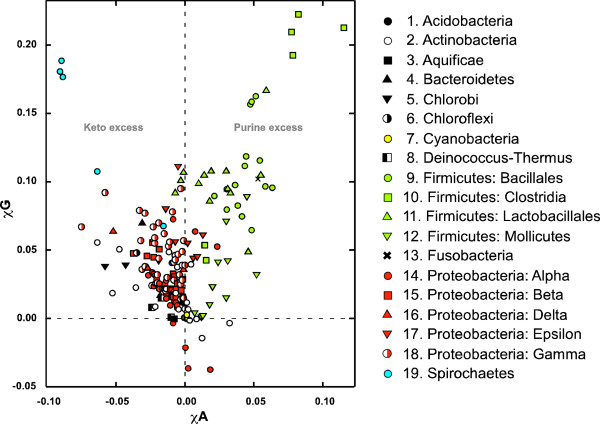
Scatter-plot analysis of base composition skews – χG vs. χA. The χG values and χA values of 185 bacterial chromosomes are plotted against each other. The symbols for the 19 groups of bacterial chromosomes (1–19) are listed on the right. The 'Keto Excess' and the 'Purine Excess' trends in Quadrant I and II are indicated.